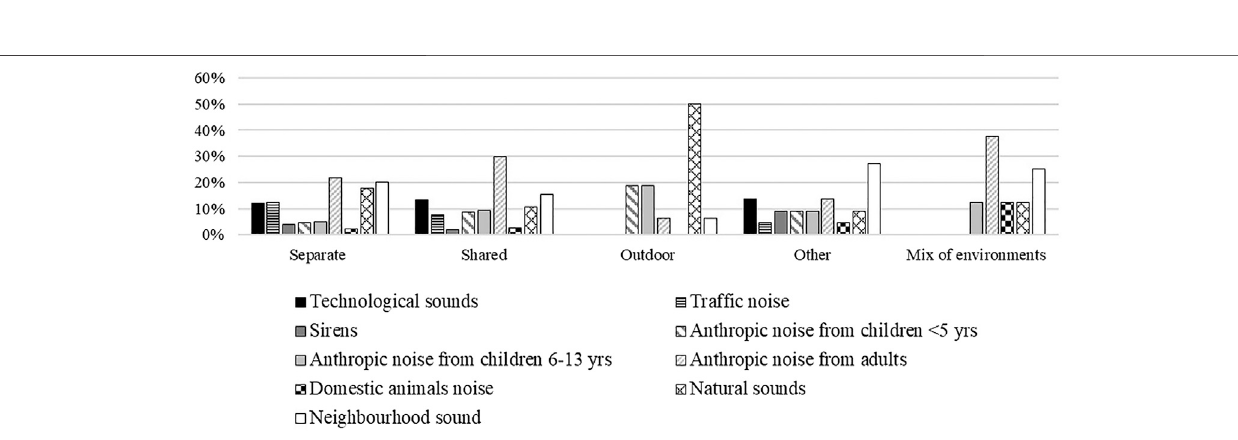
Frontiers in Built Environment |